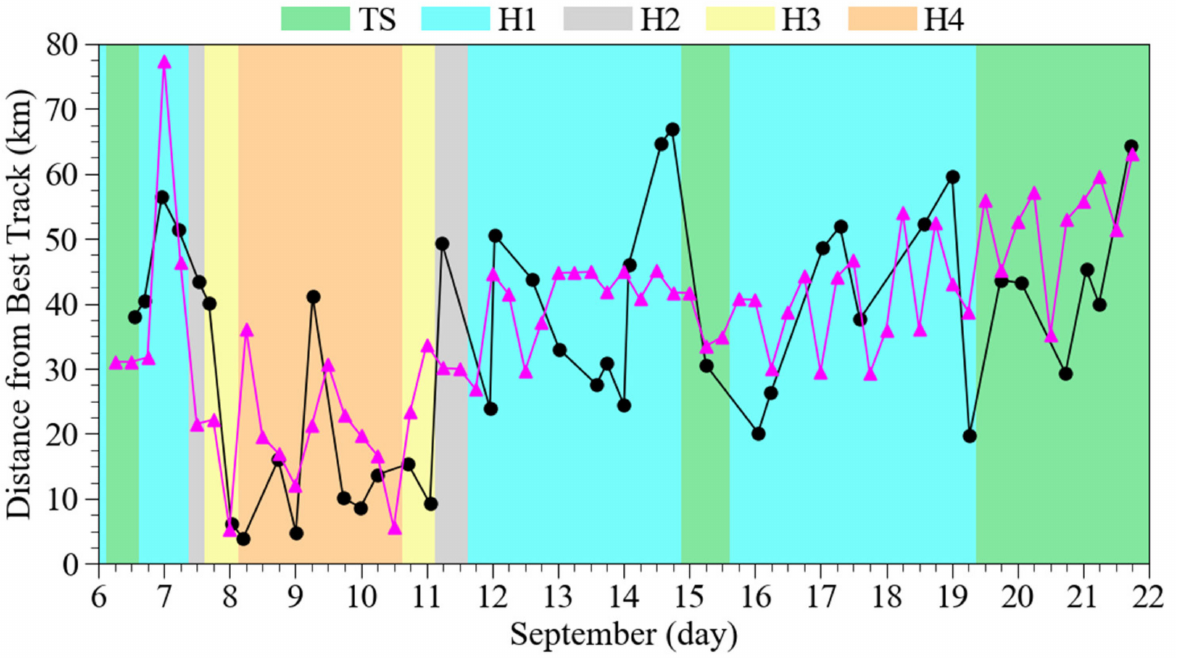
Figure 7. Same as Figure 5a except for Jose. The mean distances from the best track center for the ABI-determined centers and ATMS- or MHS-determined centers are about 37.4 and 34.2 km,